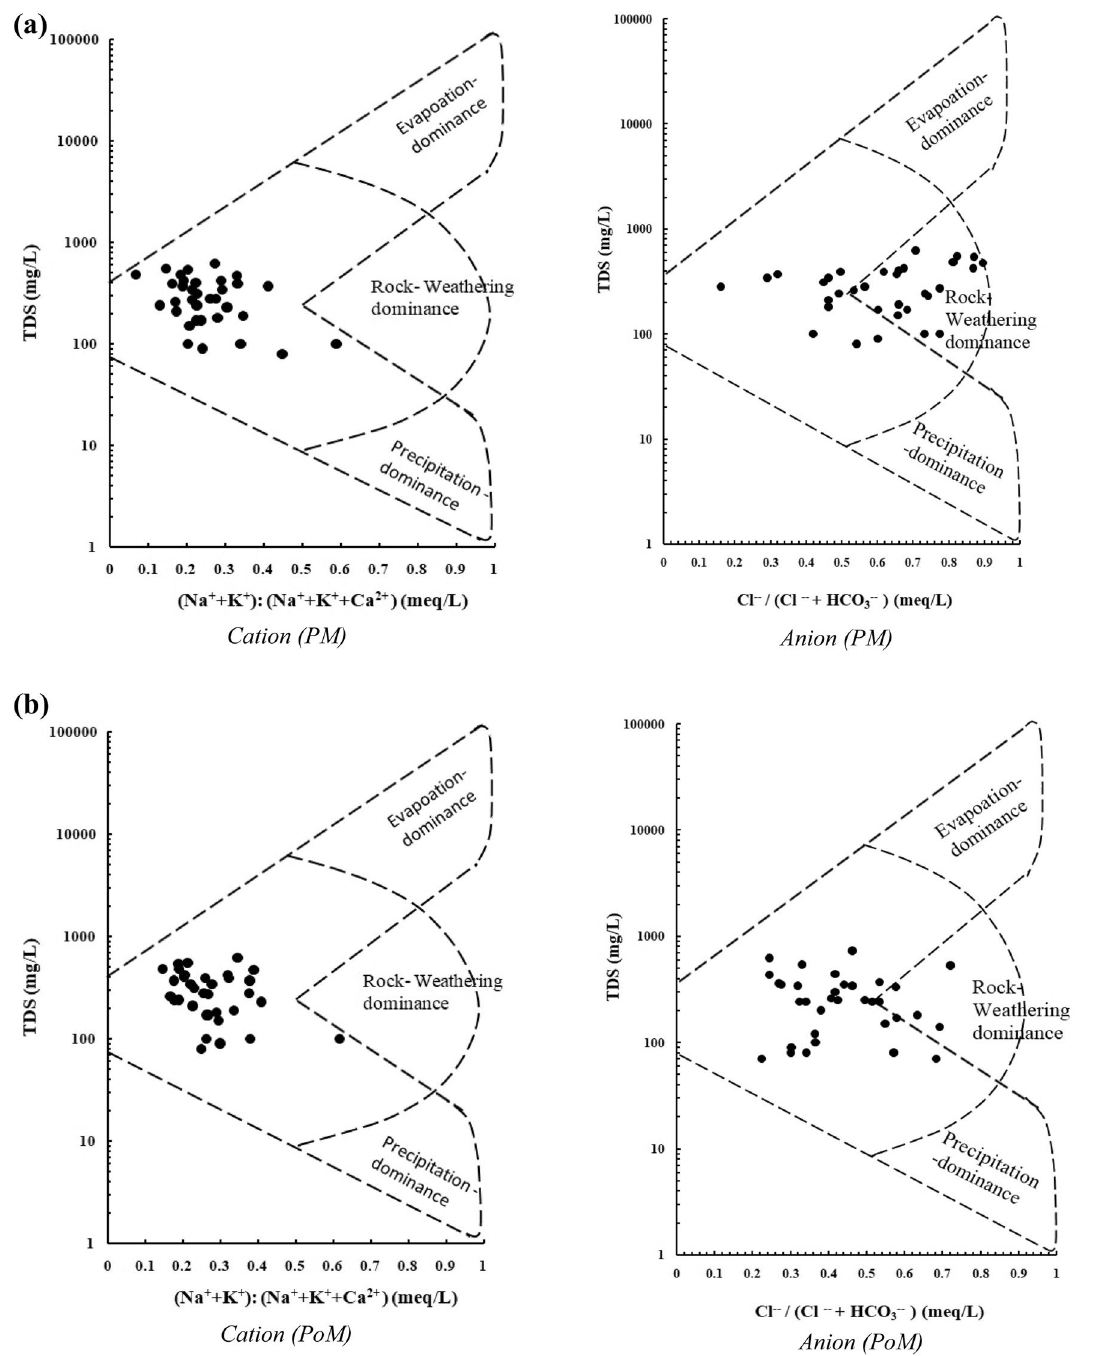
Fig. 6 The Gibbs diagram represents the rock-weathering as dominant geochemical processes during ( a ) PM and ( b ) PoM seasons for both cati- ons and